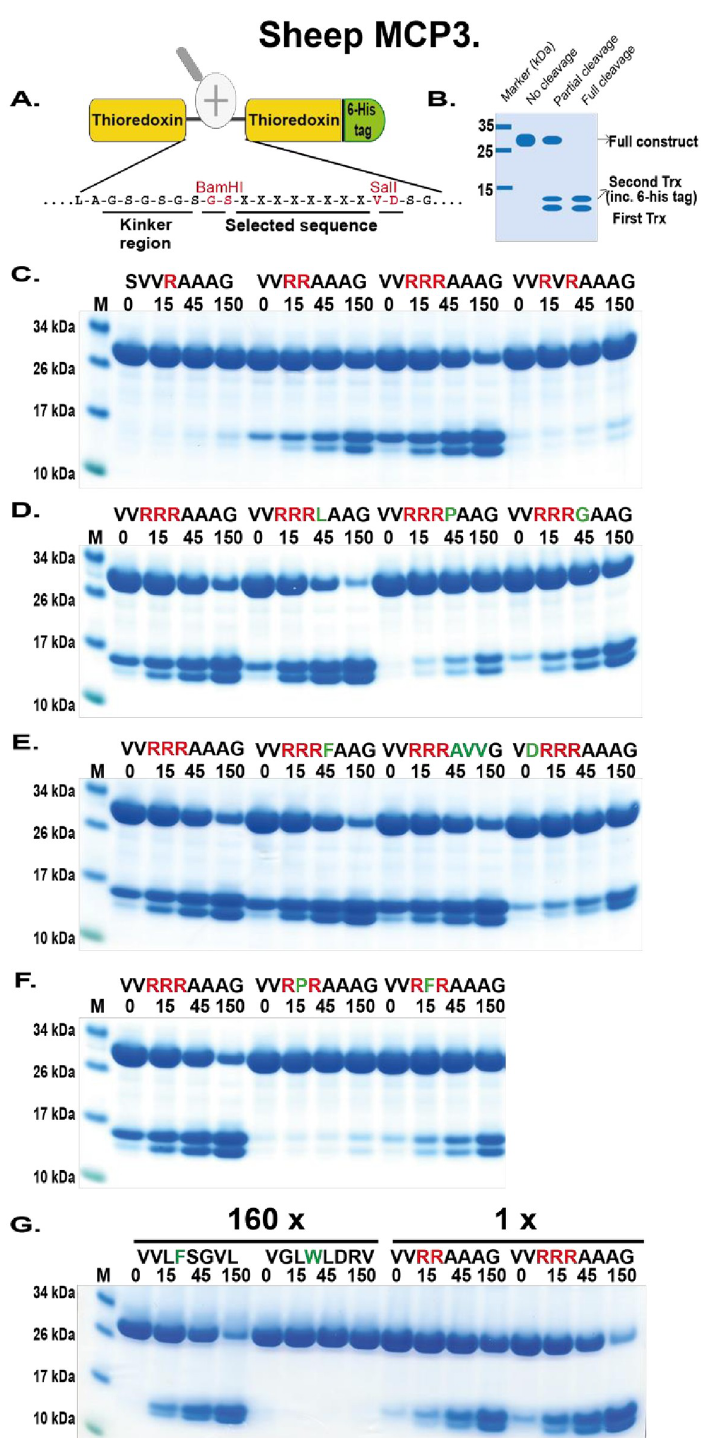
Fig 7. Verification of the cleavage specificity of sheep MCP3 using recombinant protein substrates. Panel A shows the overall structure of the recombinant protein substrates used for analysis of the efficiency in cleavage by the enzyme. In these substrates two thioredoxin molecules are positioned in tandem and the proteins have a His 6 -tag positioned in their C termini. The different cleavable sequences are inserted in the linker region between the two thioredoxin molecules using two unique restriction sites, one Bam HI and one SalI site, which are indicated in the bottom of panel